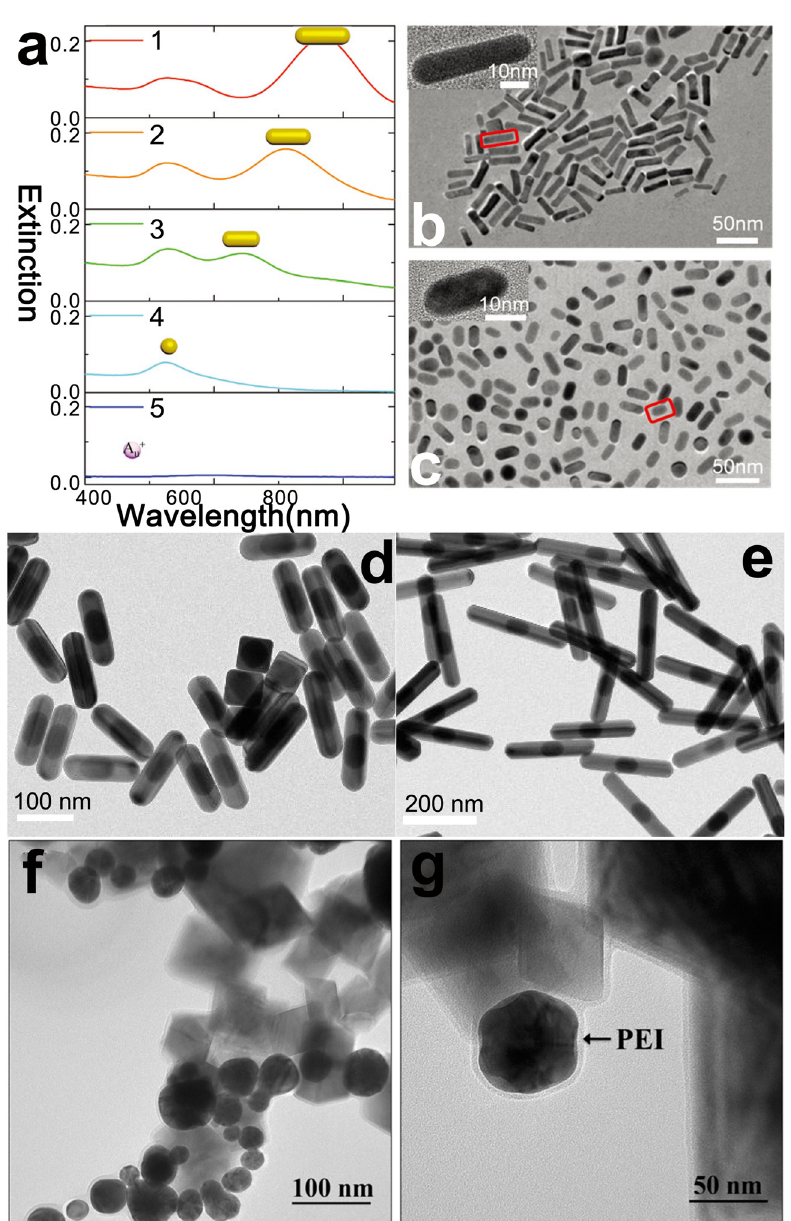
Figure 6: ( a ) Extinction spectra acquired for increasing irradiation times ( 0 min for curve 1, 90 min for curve 2, and 180 min for curve 3 ) . ( b ) TEM images of the Au NRs were taken before oxidation and ( c ) after 180 - min - long oxidation. The scale bars in the insets of ( b ) and ( c ) are 10 nm. Reproduced with permission [ 131 ] . Copyright 2018, Royal Society of Chemistry. ( d and e ) TEM image of an Au - bead@Ag NR. ( d ) Aspect ratio: 2.8 ± 0.2. ( e ) Aspect ratio: 6.0 ± 0.3. Reproduced with permission [ 133 ] . Copyright 2018, American Chemical Society. ( f and g